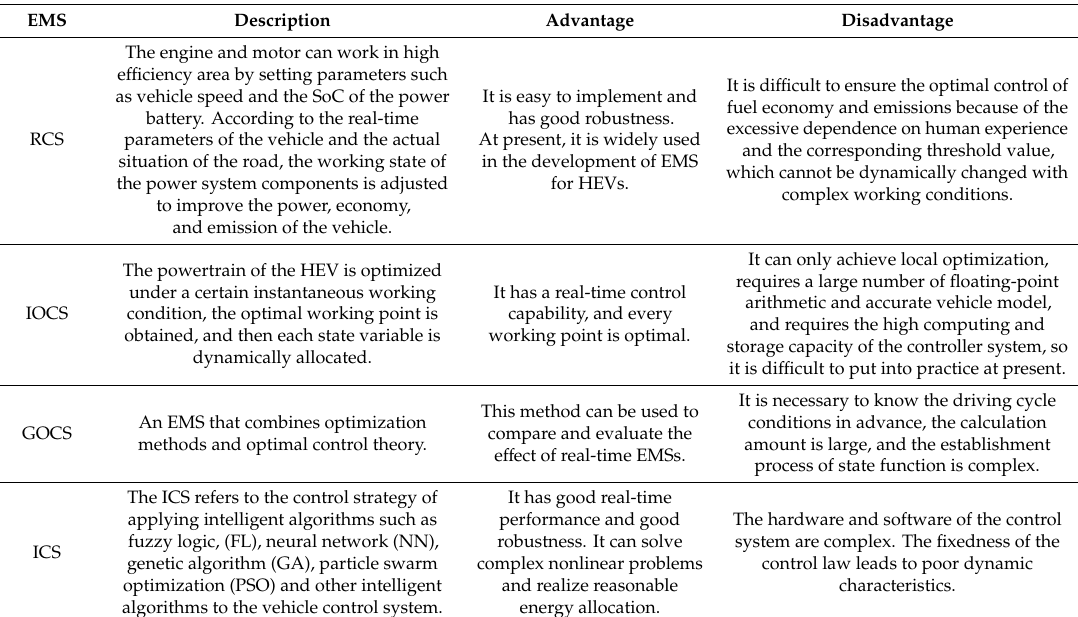
Table 3. Characteristics of energy management